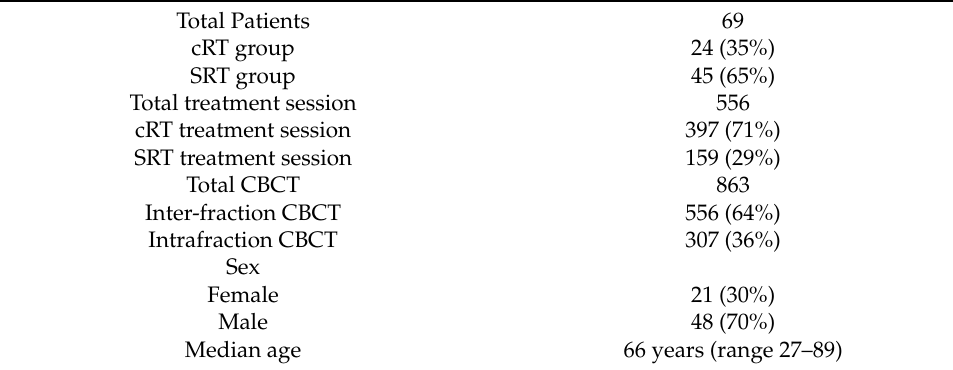
Table 1. Main characteristics of study